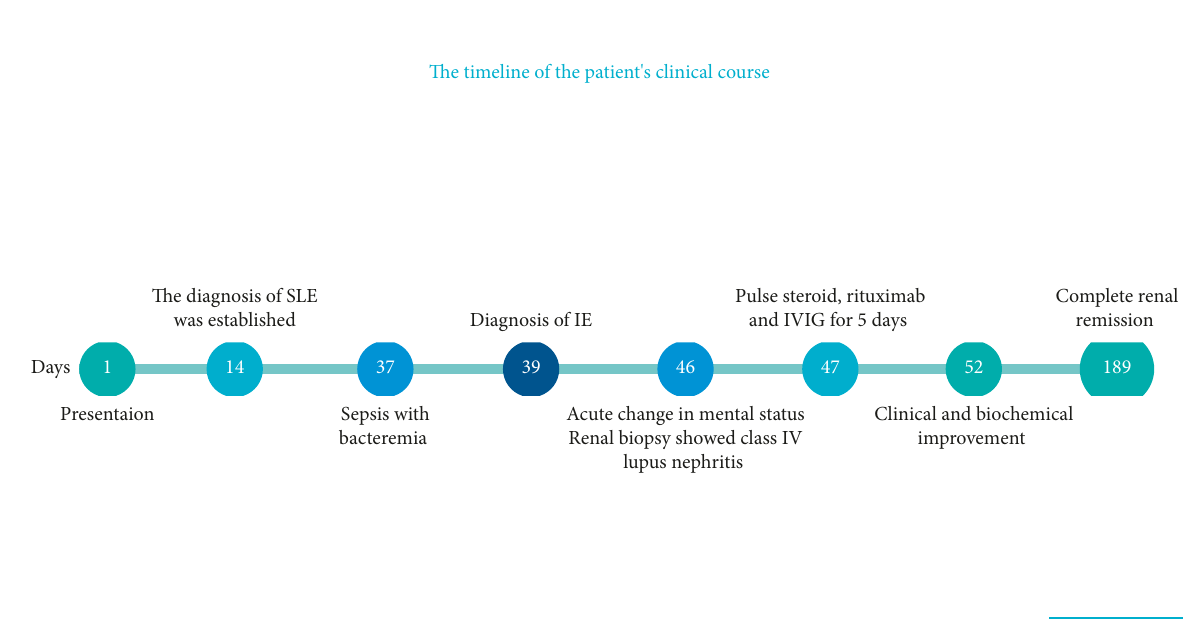
Figure 2: The timeline of the patient’s clinical course. Days are represented in circles and clinical events are arranged